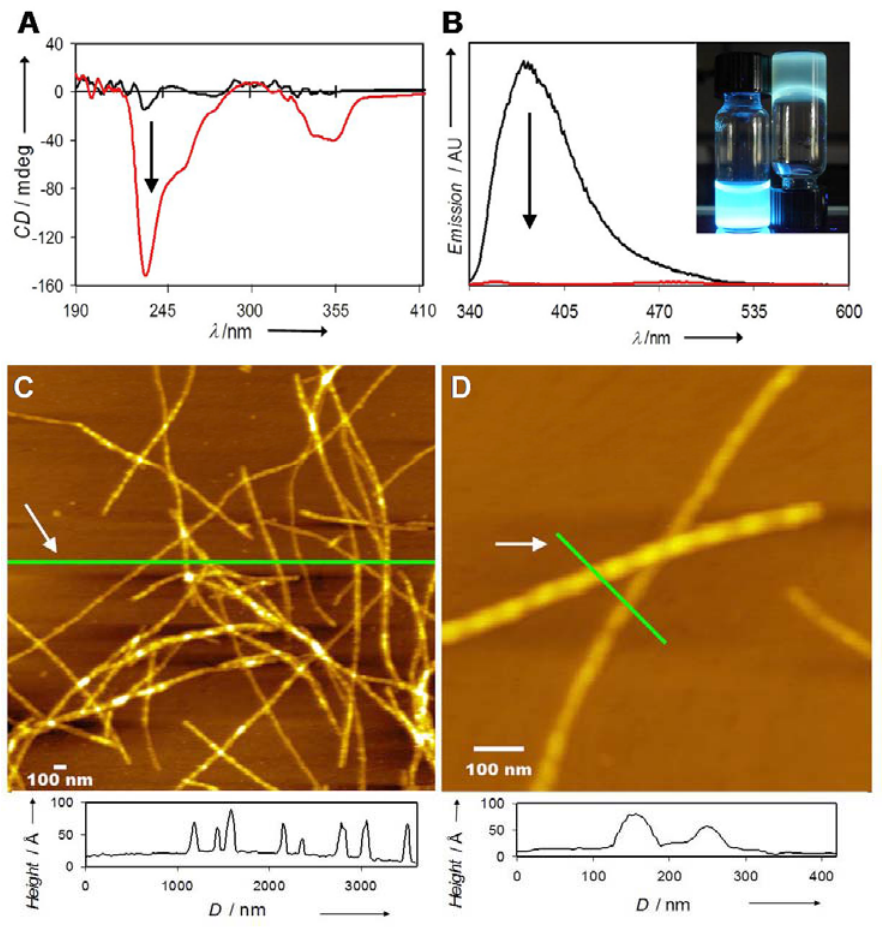
Figure 5. (A) Circular dichroism and (B) fluorescence of QQEFA in basic (dissolved, black traces) and acidic (assembled, red traces) aqueous solutions. The inset of (B) depicts a concentrated solution (left) and a gel (right) irradiated at 365 nm. Tapping-mode atomic force microscopy images and height profiles of the indicated line trace of (C) large area surfaces. Figure taken from reference [36] with permission (Copyright 2008, American Chemical